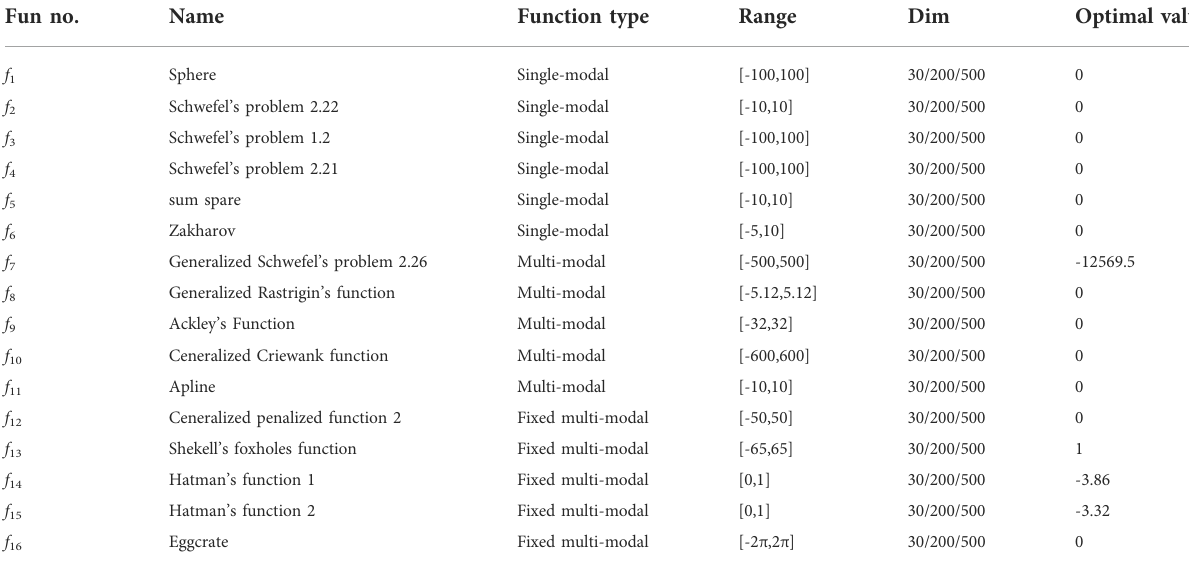
TABLE 1 Introduction to benchmark functions. Fun